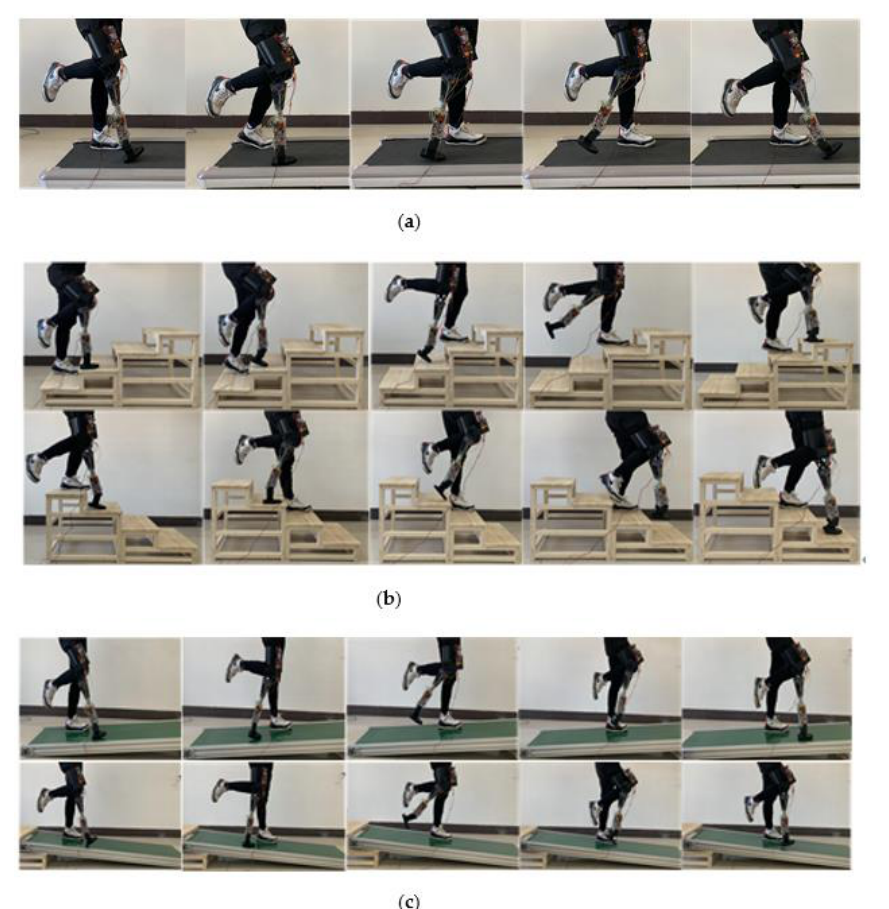
Figure 15. Prosthetic gait experiment. ( a ) Gait experiment of prosthetic flat walking (speed 1 m/s). ( b ) Gait experiment of prosthetic leg up and down steps (four steps). ( c ) Gait experiment of prosthetic ups and downs (gradient 5 degrees).